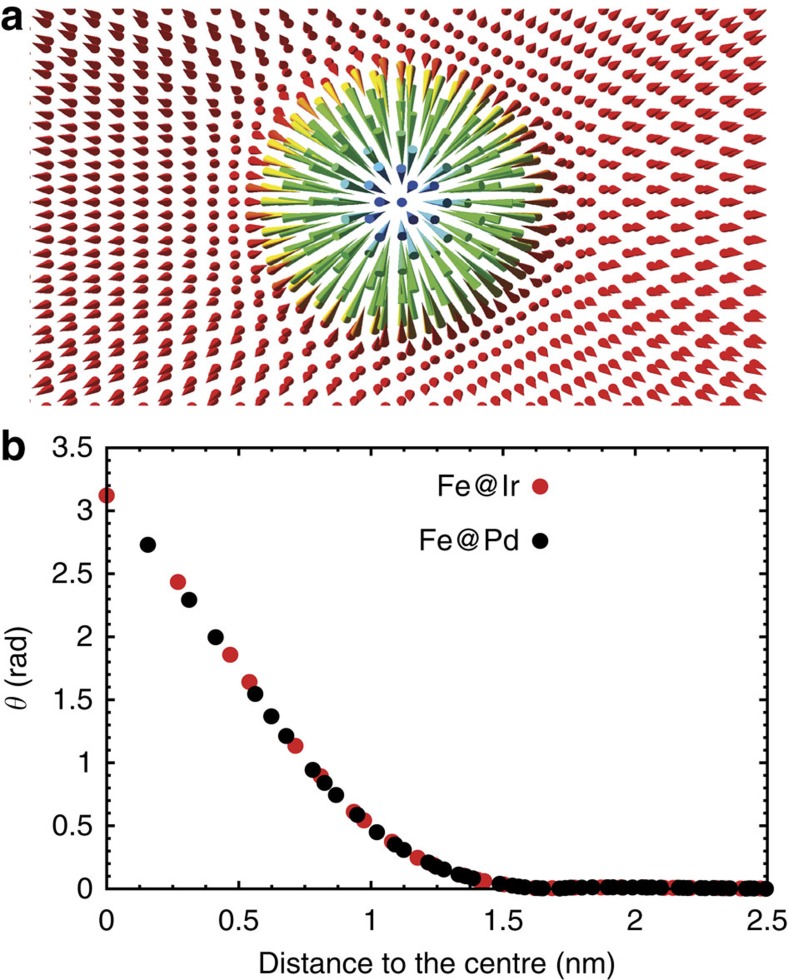
Skyrmion profile in the multilayer Rh/Pd/2Fe/2Ir.(a) Top view of the magnetization of the skyrmion with red arrows pointing up and green/blue arrows pointing down. (b) Magnetization profile of an isolated skyrmion at a magnetic field of B=3.5 T averaged at a given radial distance r from the centre. The polar angle θ of the magnetization vector is shown as a function of r. Red dots correspond to the Fe atoms at the Fe/Ir interface and the black dots correspond to the Fe atoms on the Pd side.